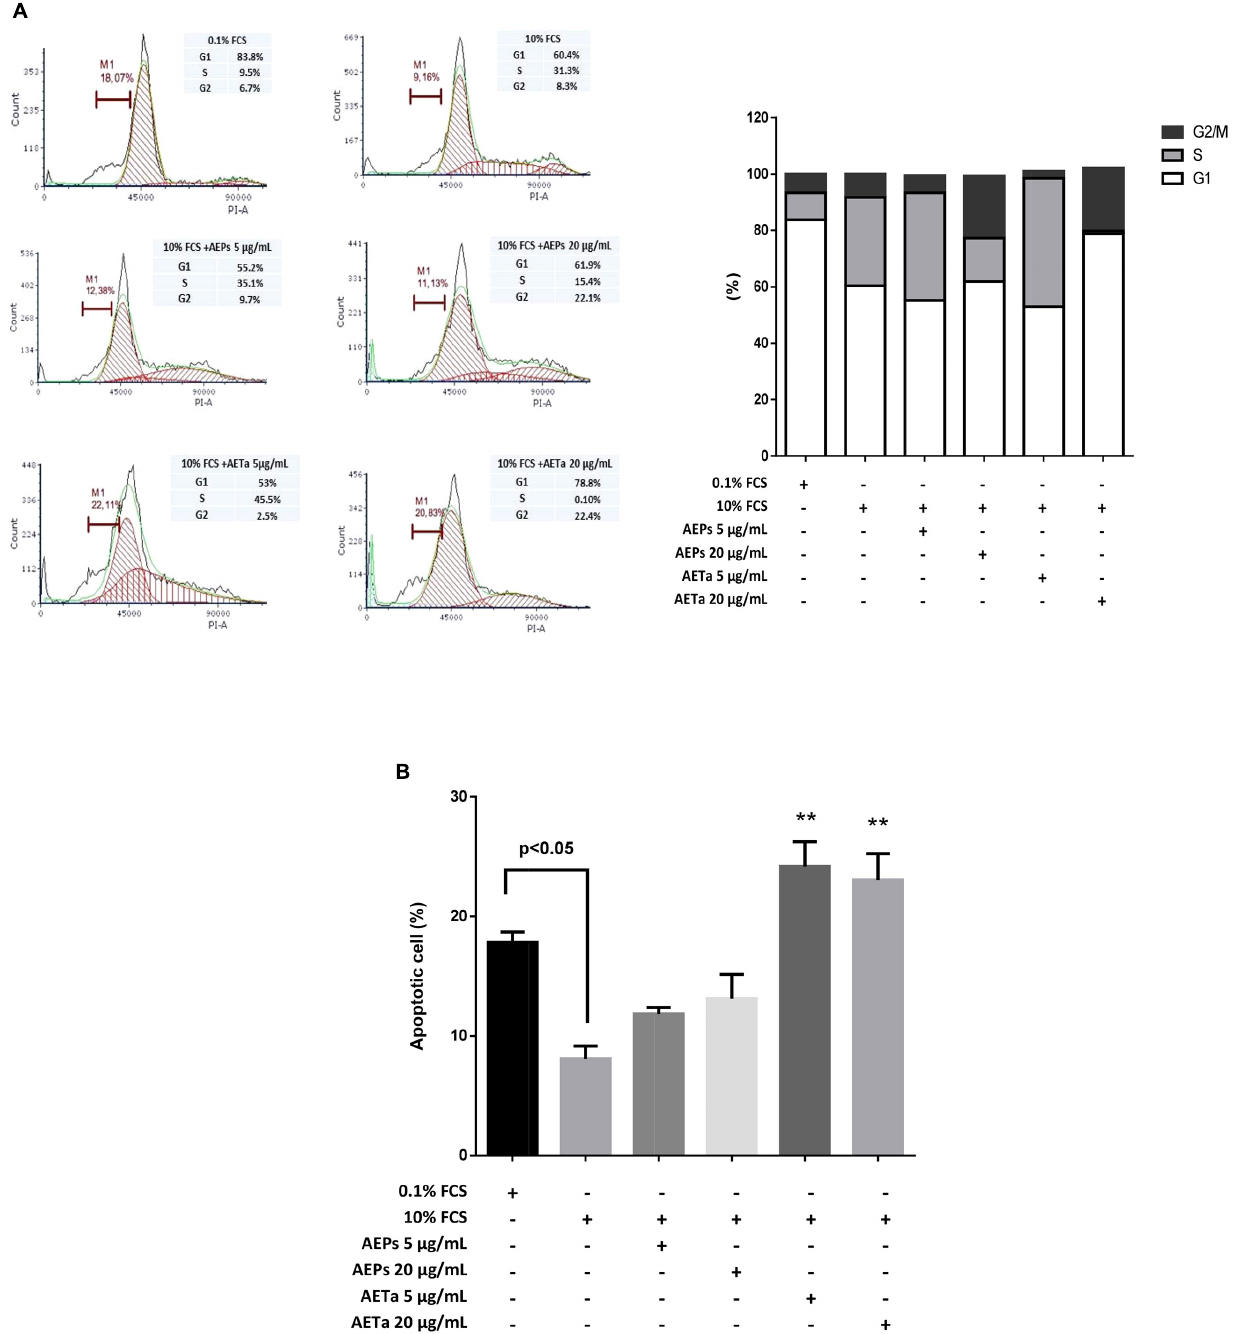
Frontiers in Physiology |